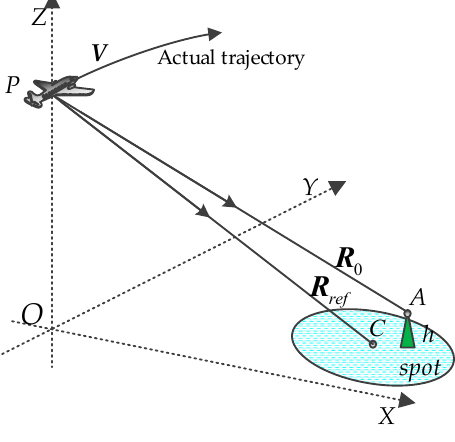
Figure 1. Geometrical model of high-resolution airborne synthetic aperture (SAR).